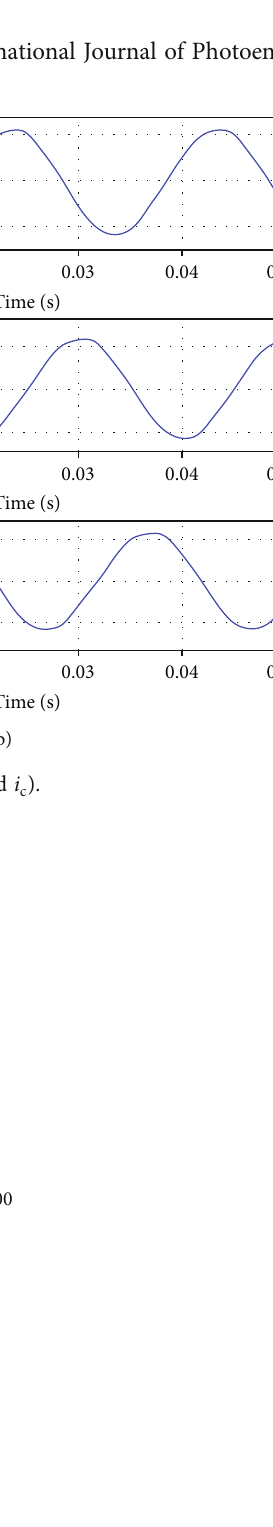
Figure 11: Spectrums of (a) neutral voltages ( V